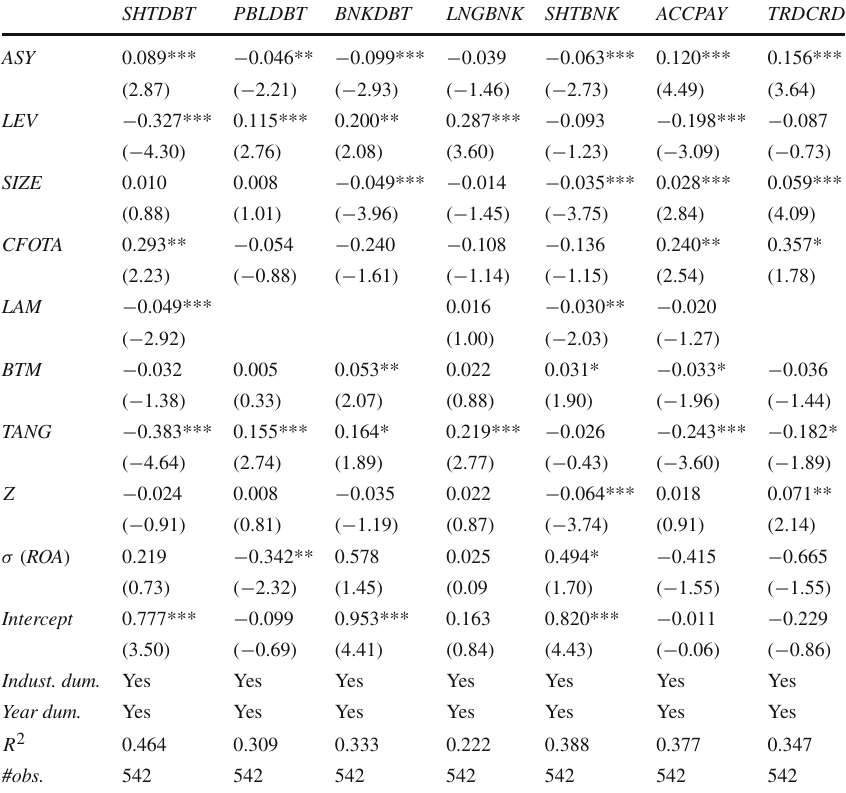
Table 6 Effect of information asymmetry on different types of debt